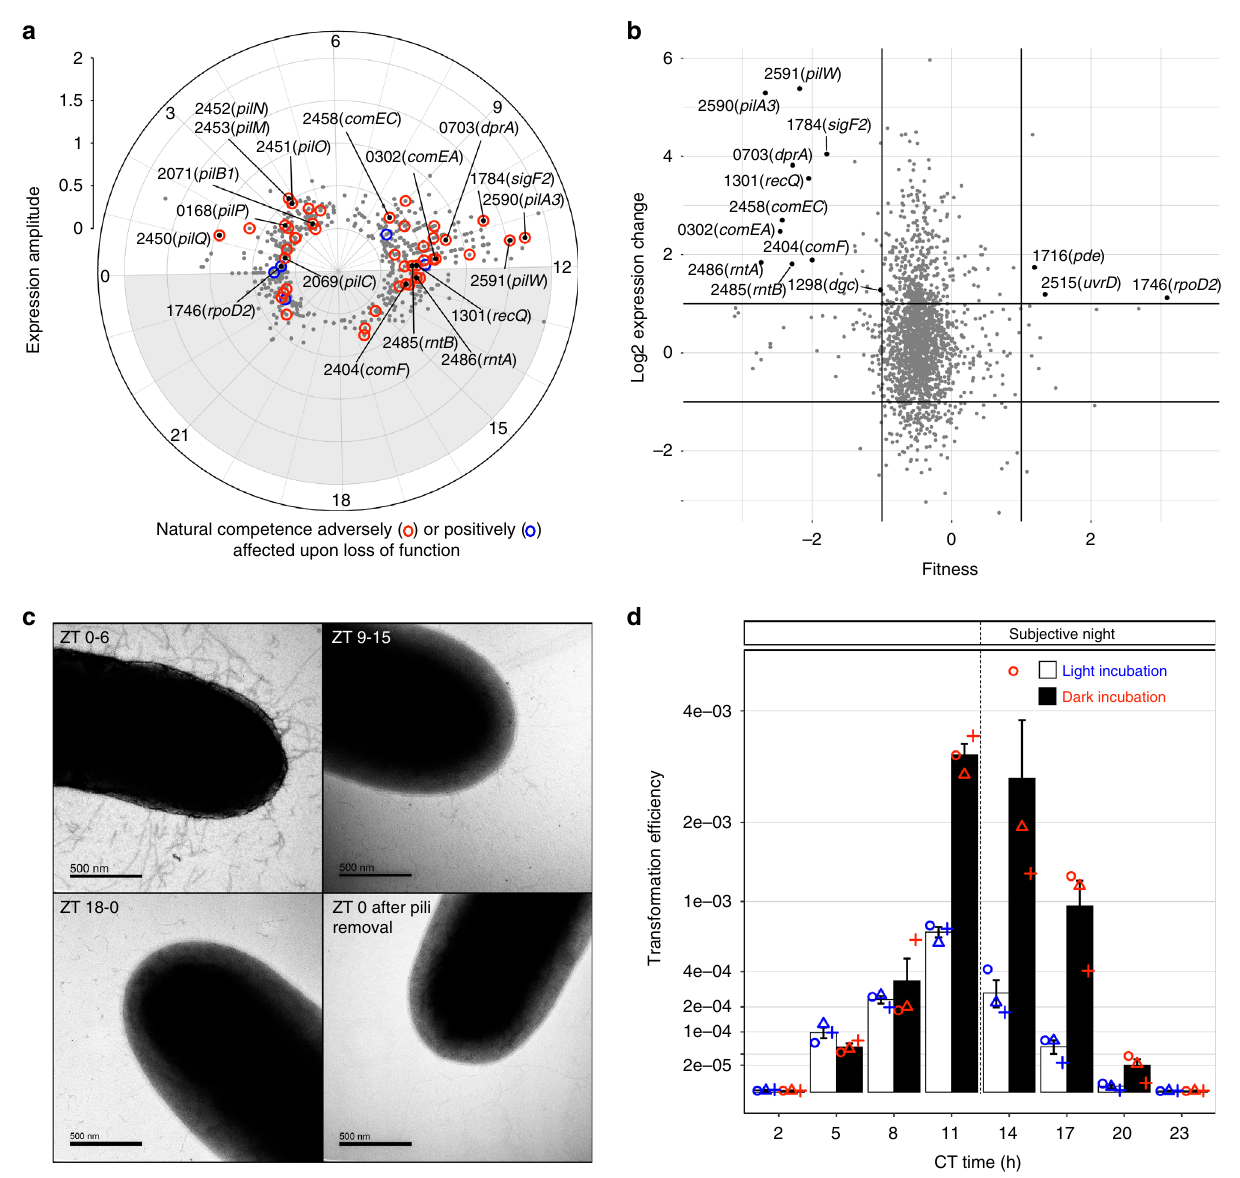
Fig. 3 Natural competence is under circadian control and induced in the dark. a Amplitude of circadian-expressed genes reported at peak time, calculated from S. elongatus circadian transcriptomics 24,36 . Most of the T4PM genes (including pilB, M, N, O, P, Q ) are circadian controlled and expressed in the morning while a subset of genes needed for natural transformation such as pilA3, pilW , and rntA and rntB , and the competence genes including comEA , comEC, comF , and dprA , are circadian with highest expression levels at dusk. A red circle indicates a gene whose loss of function adversely affects natural competence and a blue circle indicates a gene whose loss of function positively affects natural competence. b Expression change for genes after a 60-min shade pulse given 8 h after the onset of the day 37 , plotted according to RB-TnSeq fi tness values as described for Fig. 1. c Transmission electron micrographs of cells grown in LD and incubated at different time points (Zeitgeber time, ZT time) for 6 h after removal of their pili. Electron micrographs were chosen as representatives of 5 – 10 pictures of cells selected randomly and prepared from two biologically independent cultures for each time point. d Transformation ef fi ciency over a 24-h circadian cycle. Entrained cells of WT S. elongatus released in LL were incubated with eDNA at different circadian time points